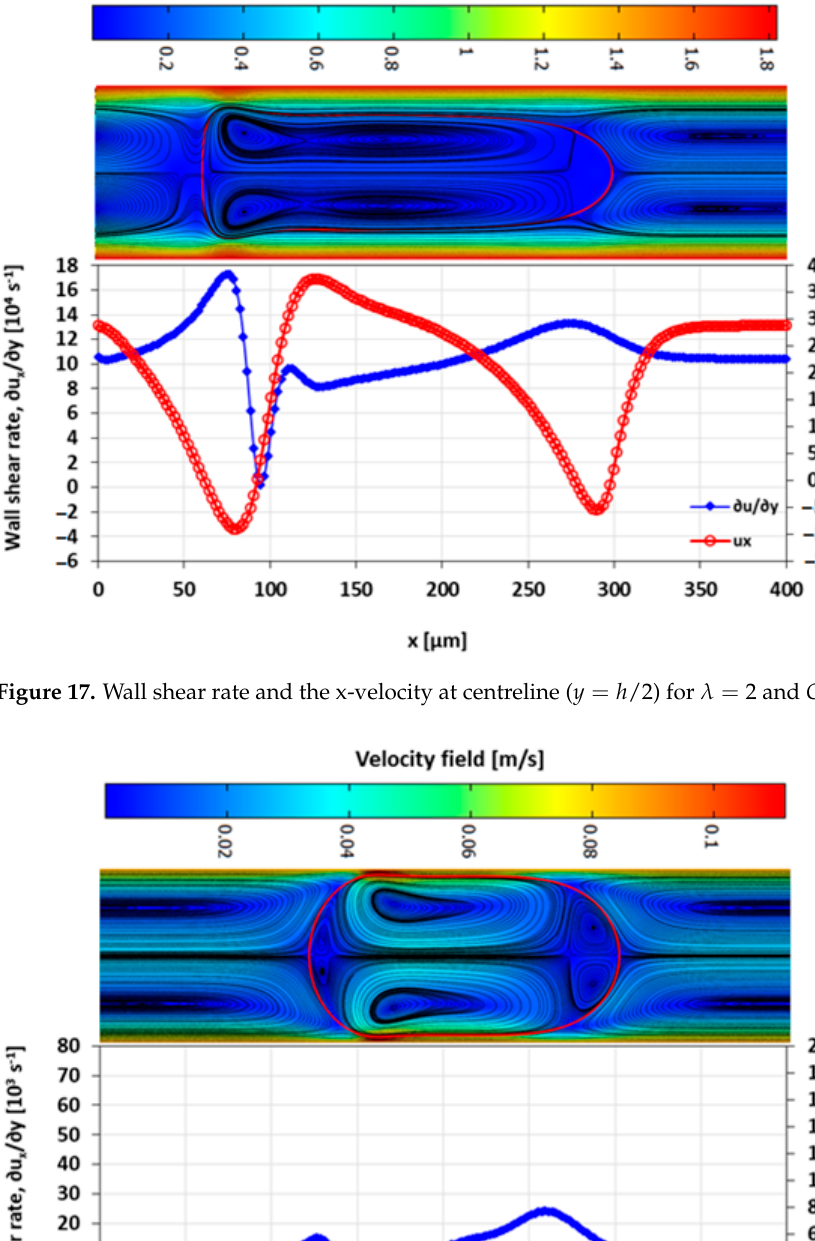
Figure 16. Wall shear rate and x-velocity along the centreline ( 𝑦 = ℎ/2 ) at 𝜆 = 2 and 𝐶𝑎 = 0.019 .